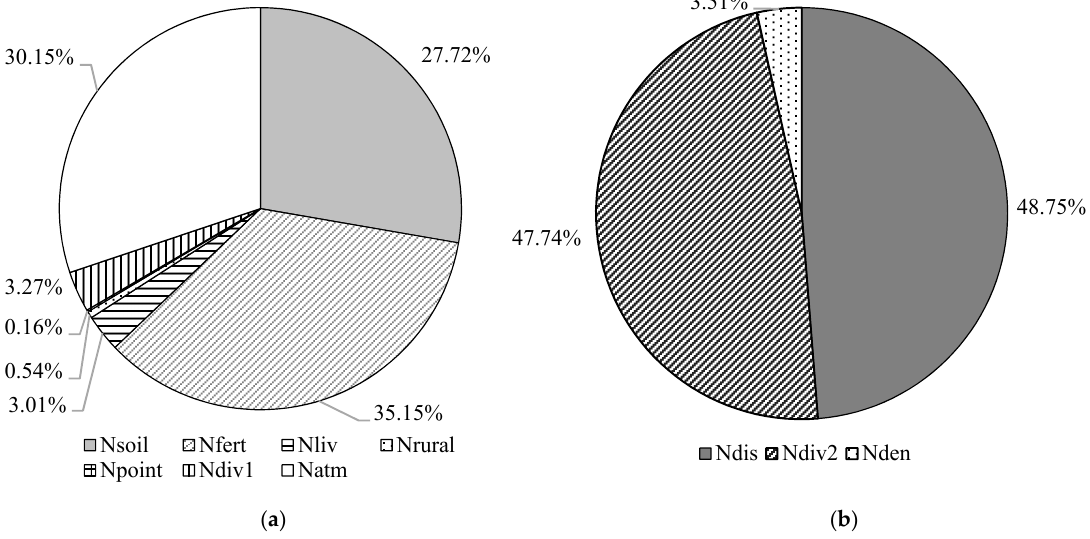
Figure 8. The average composition ratio of the TN input ( a ) and output ( b ) fluxes of the Biliuhe reservoir from 2009–2016.